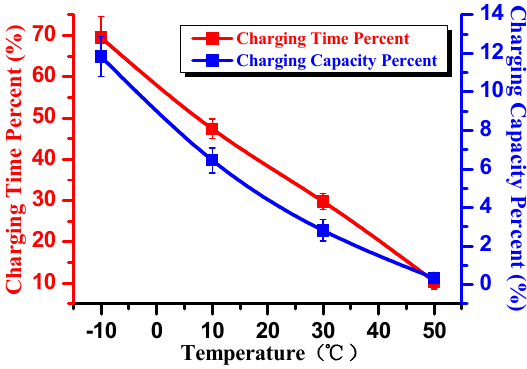
Figure 2. Charging capacity percentage and charging time percentage of CV stage in CC/CV strategy at different